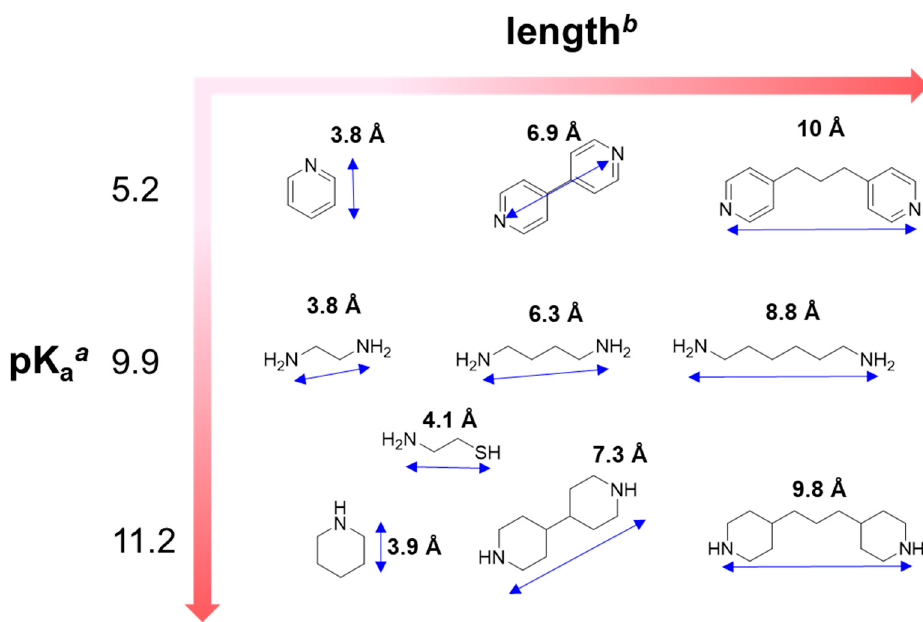
Figure 3. Guest molecules containing nitrogen atom(s). a The pK a values of pyridine [62], ethylenediamine [63], and piperidine [64] are shown on the left side of Figure. b The lengths of the molecules were computationally measured from nitrogen atom to nitrogen (or sulfur) atom for bidentate ligands and from nitrogen to hydrogen atom for pyridine and piperidine after energy minimization using the MM2 force field in Chem3D 16.0.